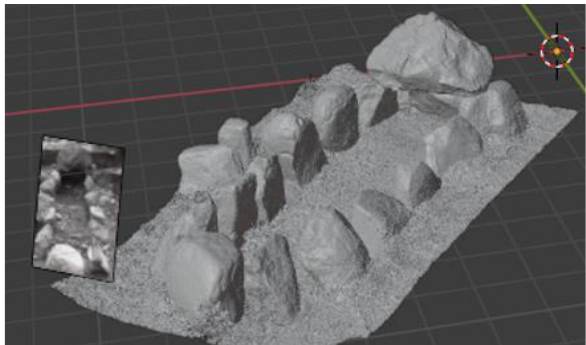
Figure 12: First idea of a visualisation of an historical image in relation to a 3D model using the software